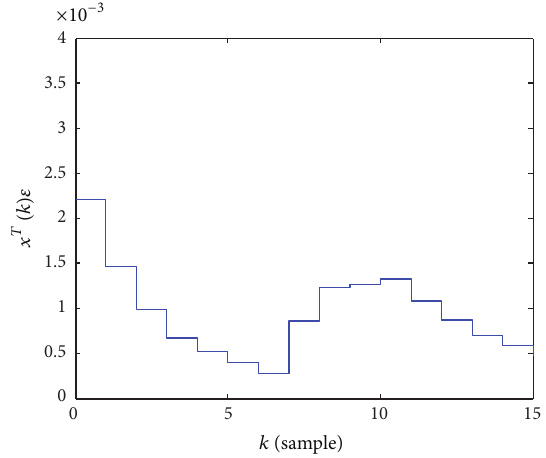
Figure 4: The evolution of 𝑥 𝑇 (𝑘)𝜀